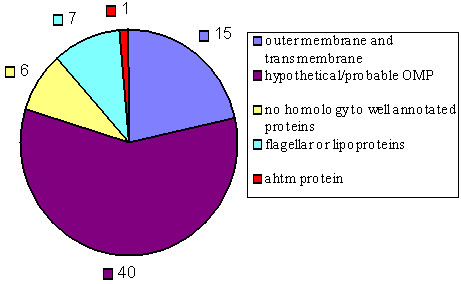
Uniprot annotation of predicted E. coli bbtm proteins. Numbers of E. coli O157:H7 sequences with a TMB-Hunt E value <= 1 with different categories of annotation in Uniprot.